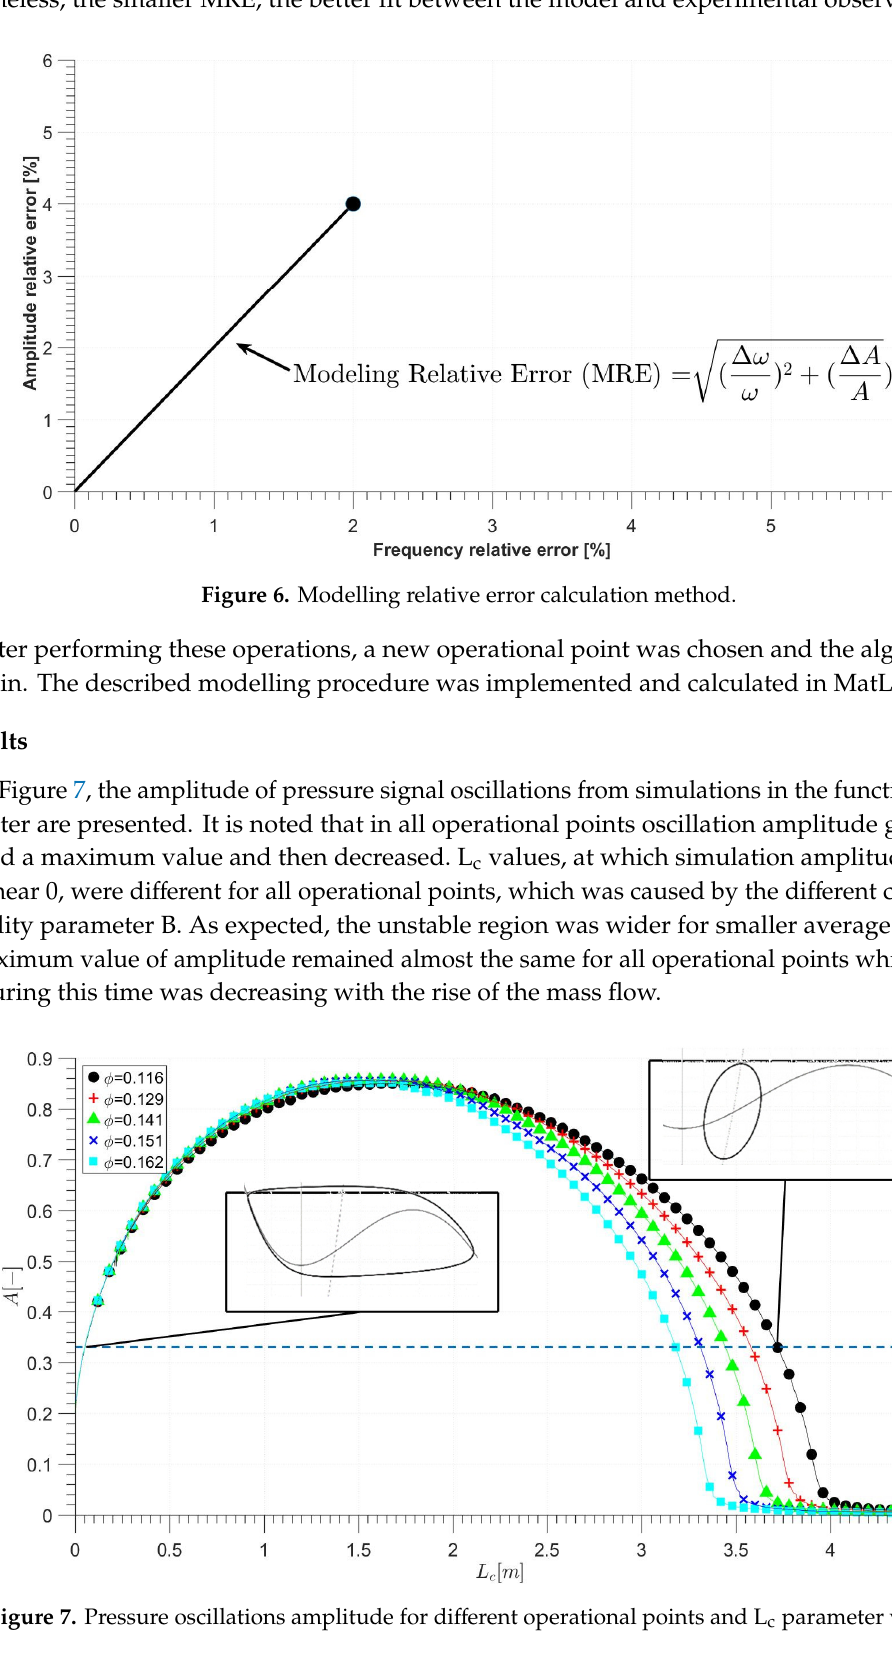
Figure 5. Modelling algorithm.